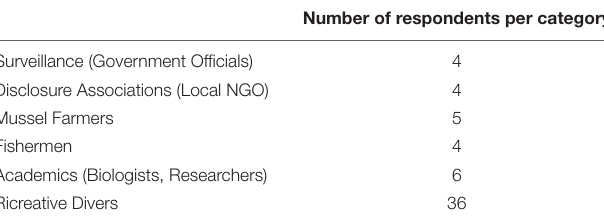
TABLE 3 | List of interviewed categories and number of respondents per